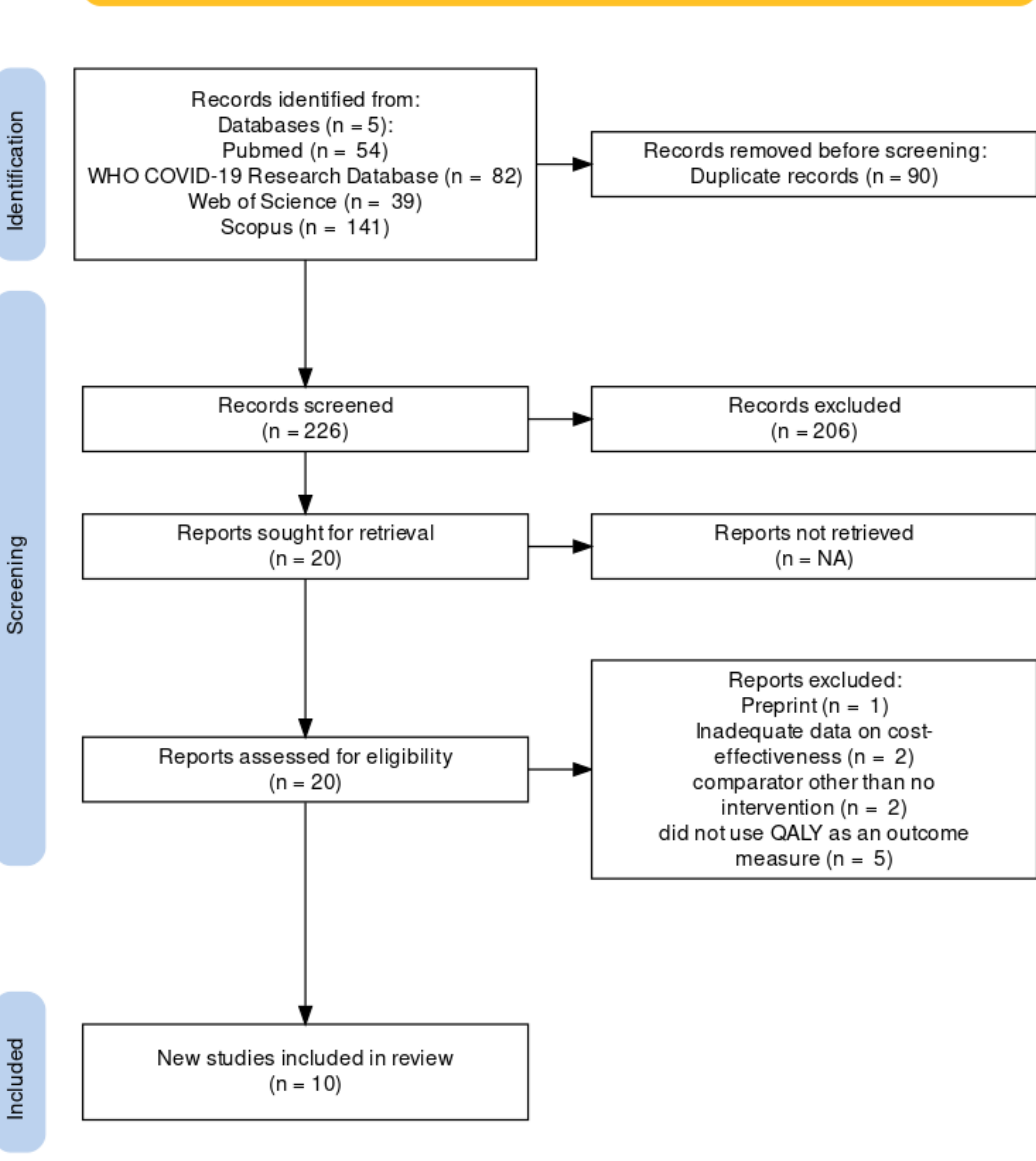
Figure 1. Study selection flow diagram.